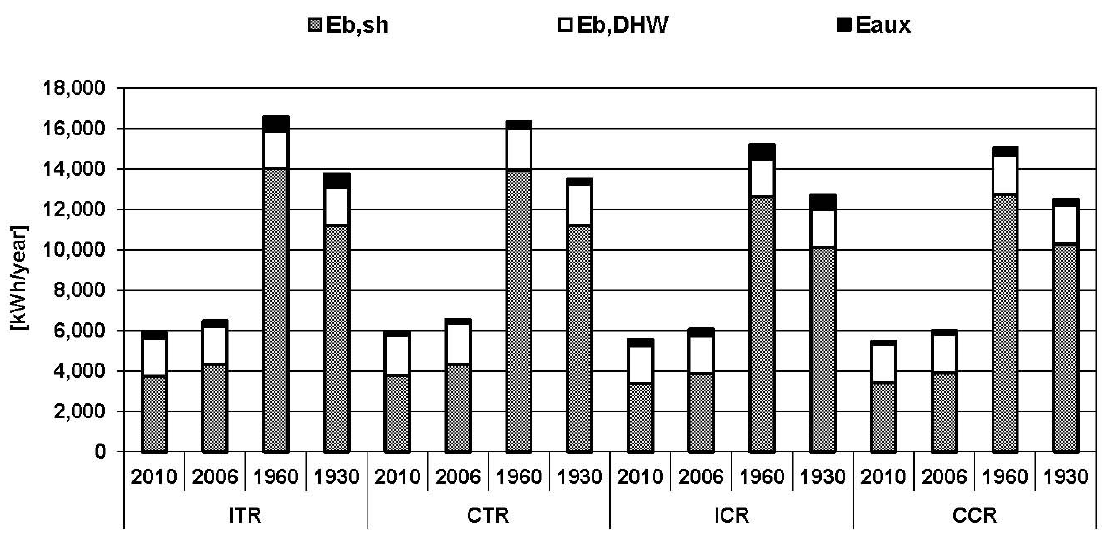
Figure 10. Primary energy needs of ITR, CTR, ICR and CCR heating